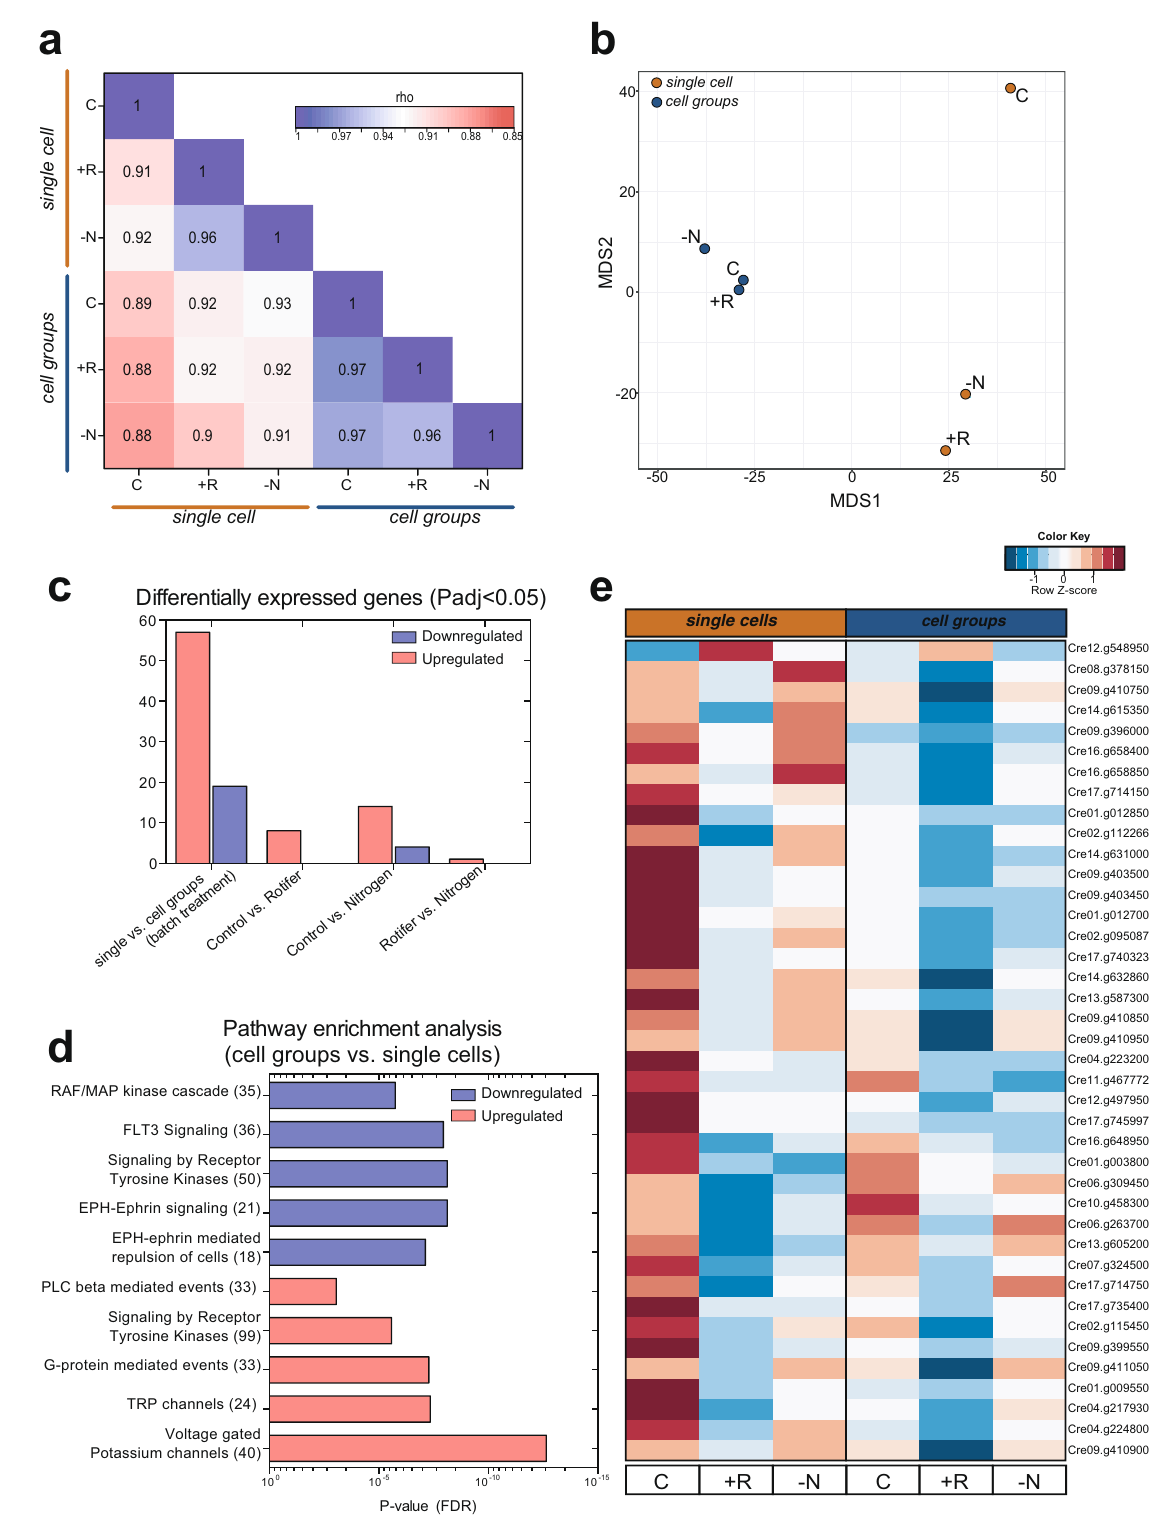
Fig. 2 Heritable transcriptome of single cells and cell groups. a Spearman correlation plot and b MDS analysis of algal transcription pro fi les for single cells (red) and cell groups (blue) clones separated by control (C), rotifer predation ( + R) and, low-nitrogen (-N) treatments. c Plot depicting differentially expressed genes for multiple comparisons. d Signi fi cantly enriched pathways in based on the differentially expressed genes of discovered for cell groups and e heatmap referring to the top40 differentially expressed genes between cell groups and single cell clones. Source data are provided as a Source Data fi le ( c